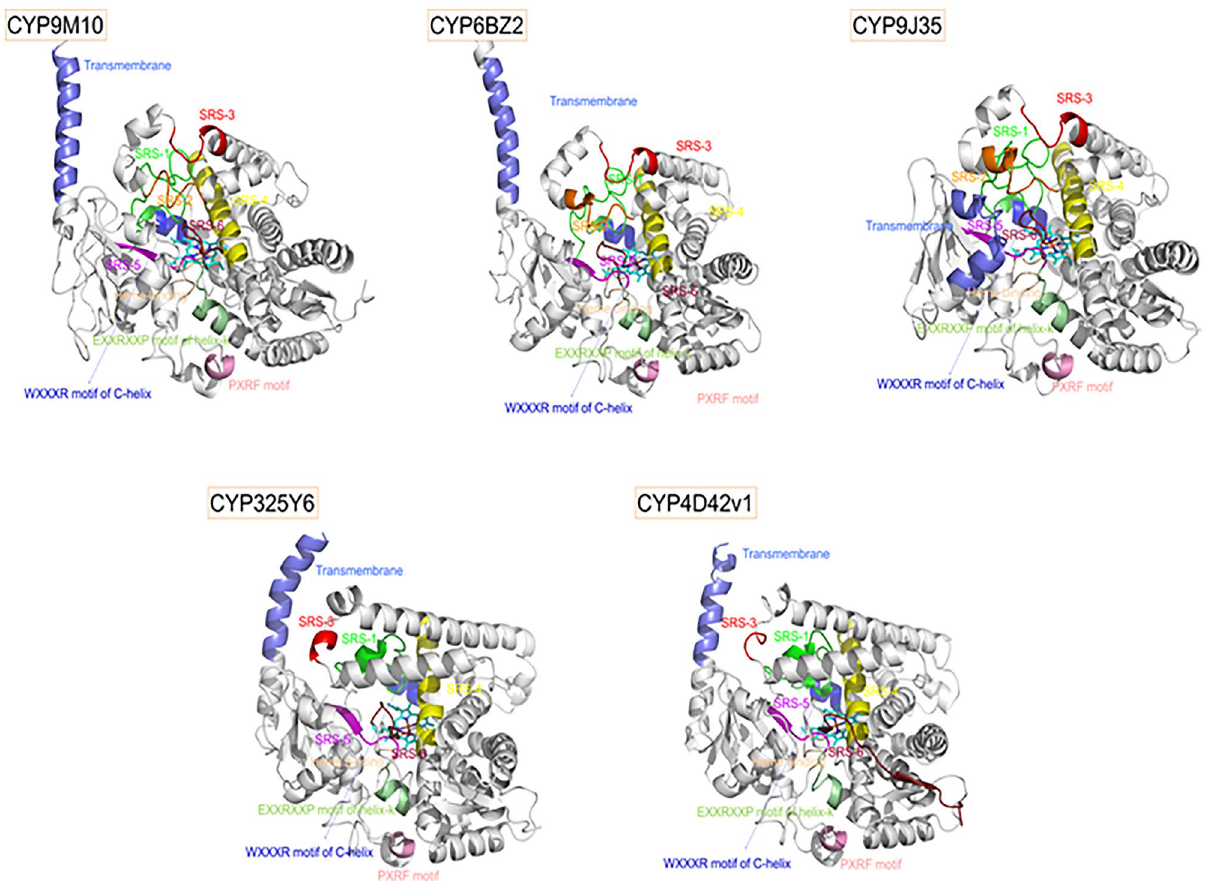
Figure 3. Homology modeling of CYP450s. The homology models for CYP9M10, CYP6BZ2, CYP9J35, CYP325Y6 and CYP4D42v1 were constructed with conserved SRSs. Motifs are labeled. Six putative SRSs are colored and predicted, according to Gotoh’s predicted models 43 . SRS1 to 6 are represented by green, orange, red, yellow, purple and ruby, respectively. The WXXXR motif of C-helix is shown in blue. The EXXRXXP motif of helix-k is shown in pale green. The PXRF motif is shown in pink and the Heme binding motif is shown in pale yellow. The HEME group is represented by cyan